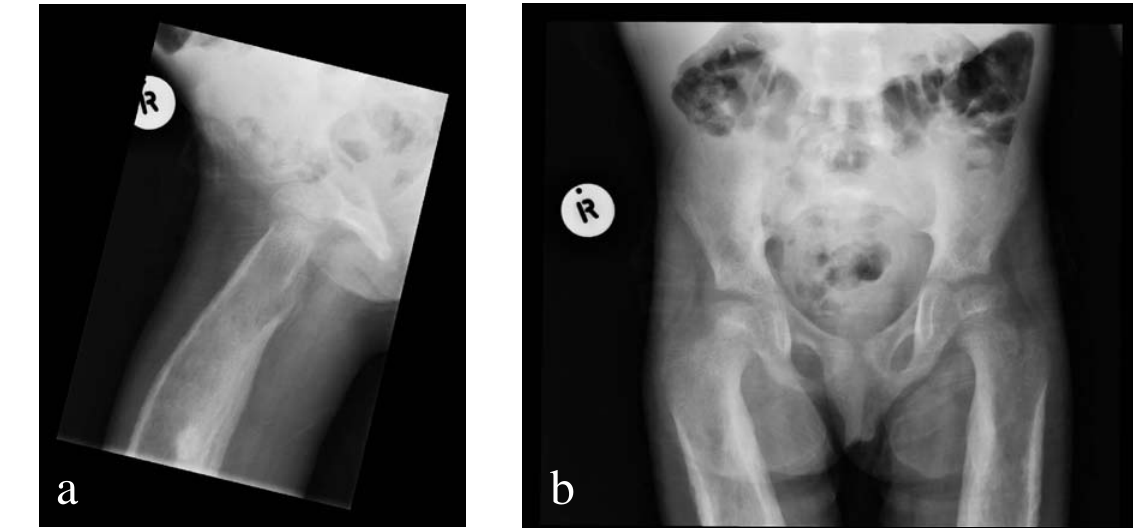
Figs 4a and b. Classical sparing of the epiphysis and metaphysis of the proximal femora.